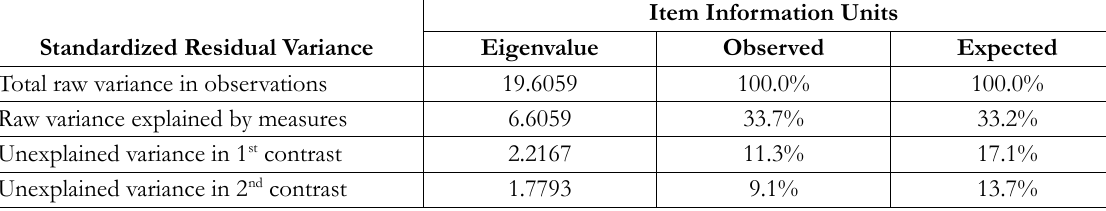
Table 2. Variance of standardized residual